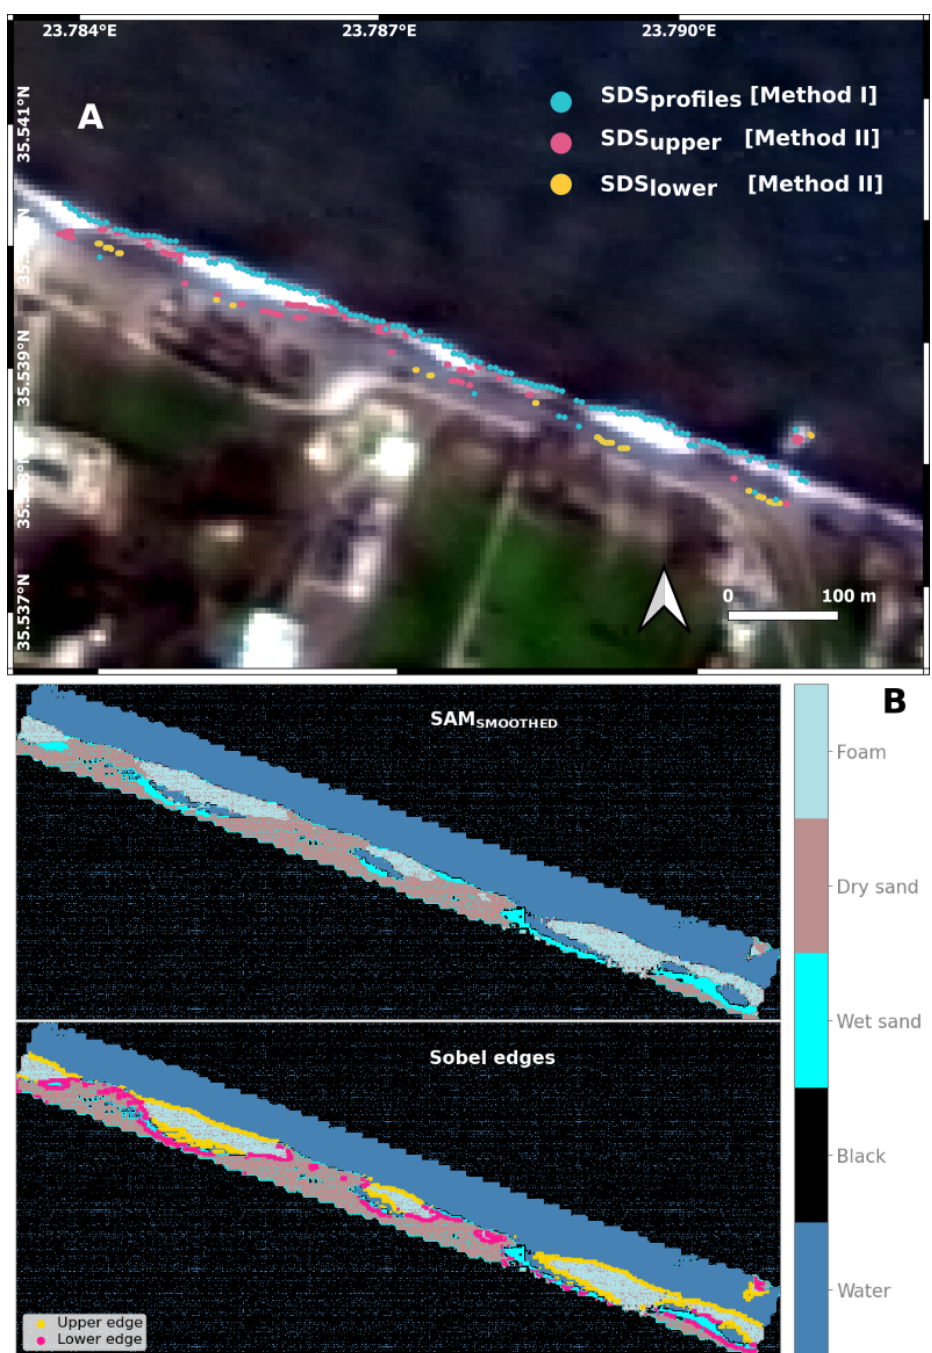
Figure 12. ( A ) SDSs obtained in the Kolymvari beach with the two methods ( B ) Upper and lower Sobel edges, resulting from the modification of the Method II: k-means to take into account the foam